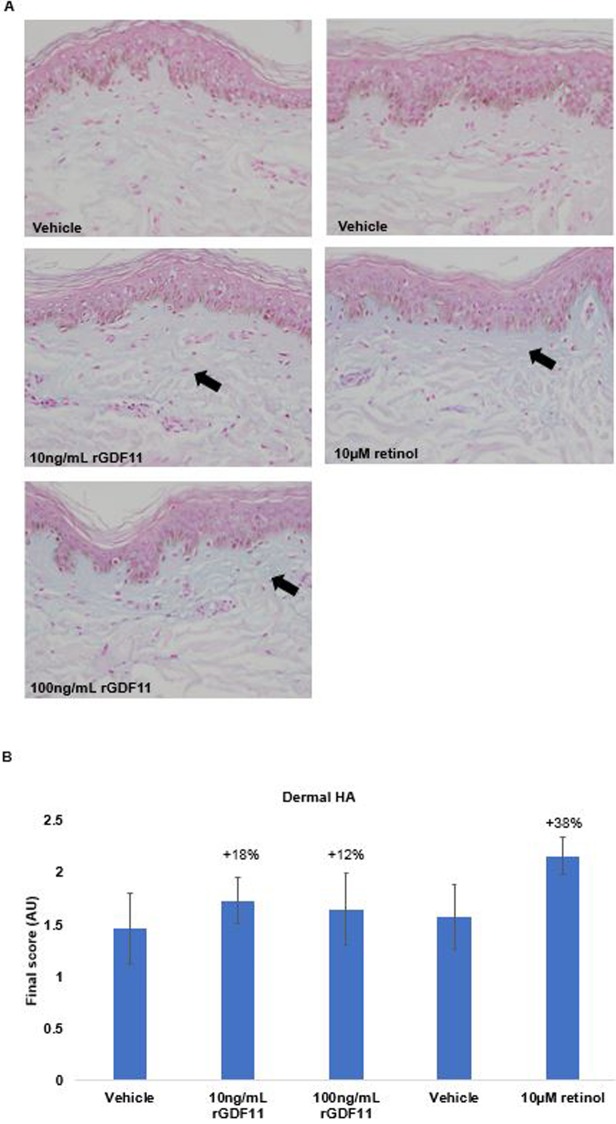
Effect of rGDF11 on hyaluronic acid production in human skin explants.(a) Representative images of hyaluronic acid staining. Replicate (n = 8) skin explants were cultured for 3 days in modified Williams’ E medium and were treated daily with rGDF (added to the media at concentration of 10 ng/ml or 100 ng/ml), retinol (10 μM topical 4μL), or corresponding vehicle. Twelve sections were stained with alcian blue stain and the amount of hyaluronic acid was determined by image analysis. (b) Comparison of hyaluronic acid scores assigned to sections (n = 12) treated with rGDF11, retinol, or vehicle. Results are shown as the mean +/- SEM. Statistical analysis used: One-way ANOVA with permutation test: F (4,55) 0.85; p-value >0.05, followed by Tukey’s permutation test.